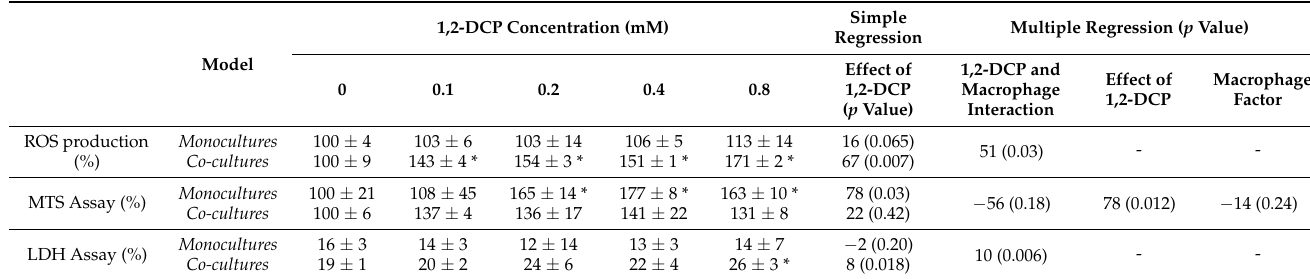
Table 2. Effects of 1,2-DCP on cytotoxicity and oxidative stress.